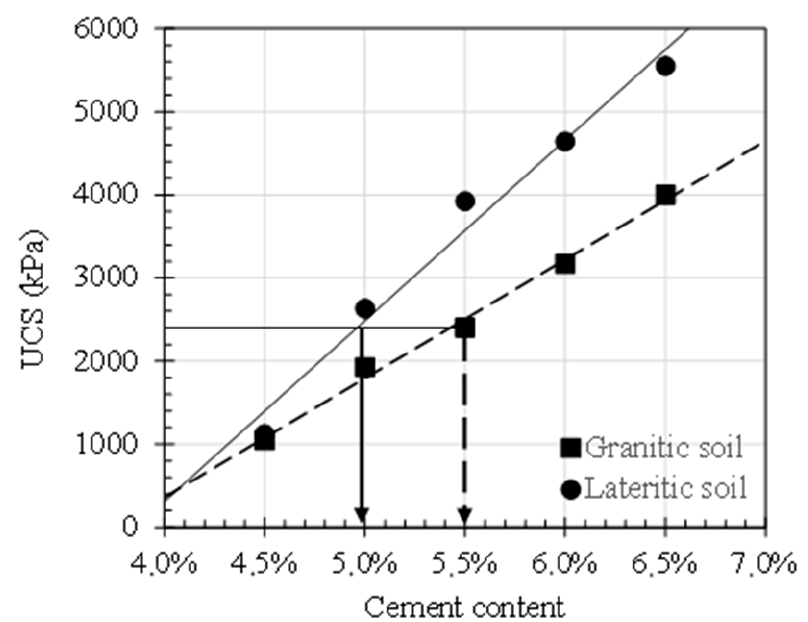
Figure 3. Optimum cement content determination.